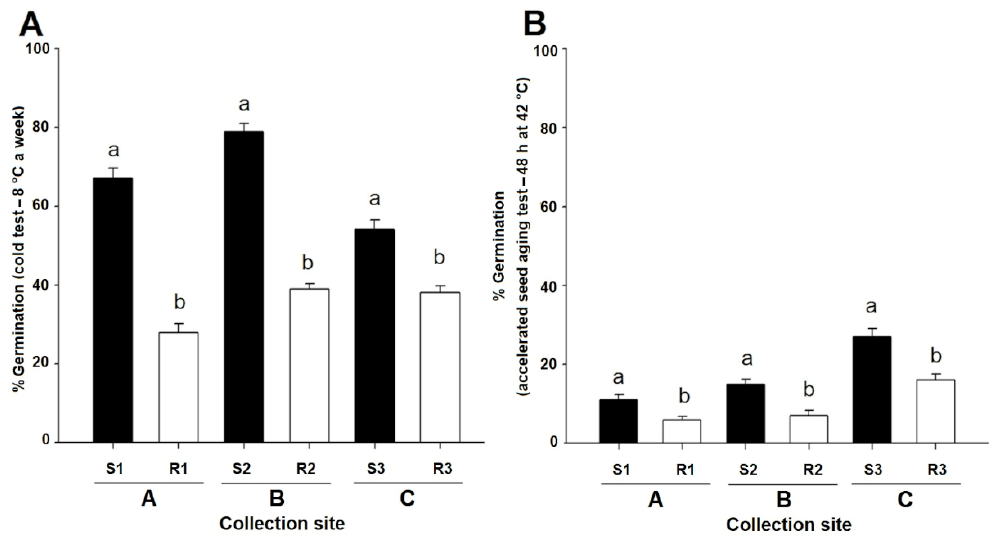
Figure 4. Seed germination under cold ( A ) and accelerated aging ( B ) tests in glyphosate-susceptible (S) and -resistant (R) Conyza bonariensis biotypes. Seeds were collected in Passo Fundo-RS ( A ), Palmeira-PR ( B ), and Matão-SP ( C ), Brazil. Vertical lines represent the standard error of means ( n = 4) using 50 seeds per replicate. Different letters denote statistical differences within a collection site according to the 95% Tukey test.